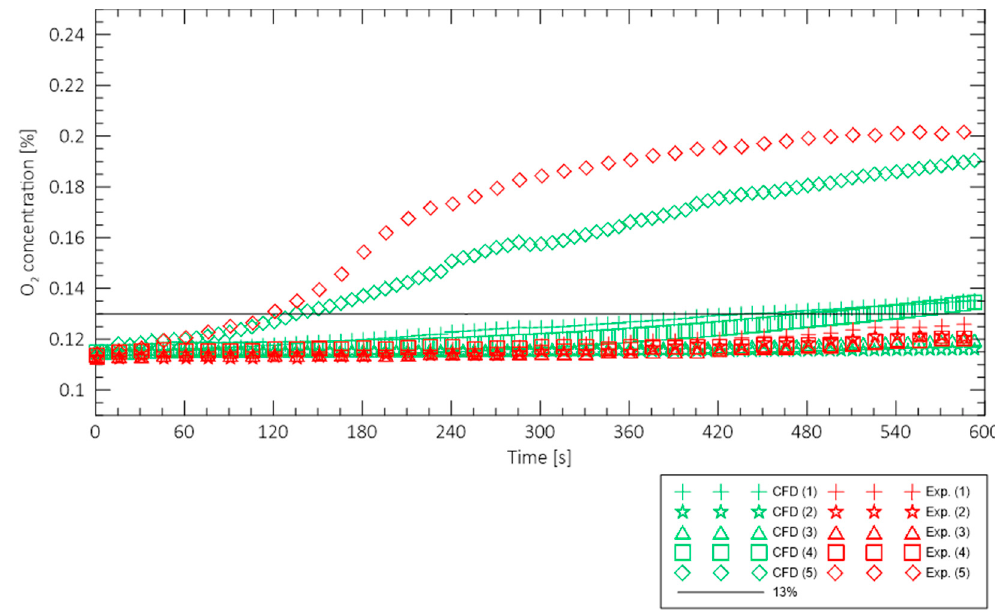
Figure 12. Changes in oxygen concentration (v/v) on all of the measurement points for fire- extinguishing gas Ar 0% v/v and N 2 100% v/v.